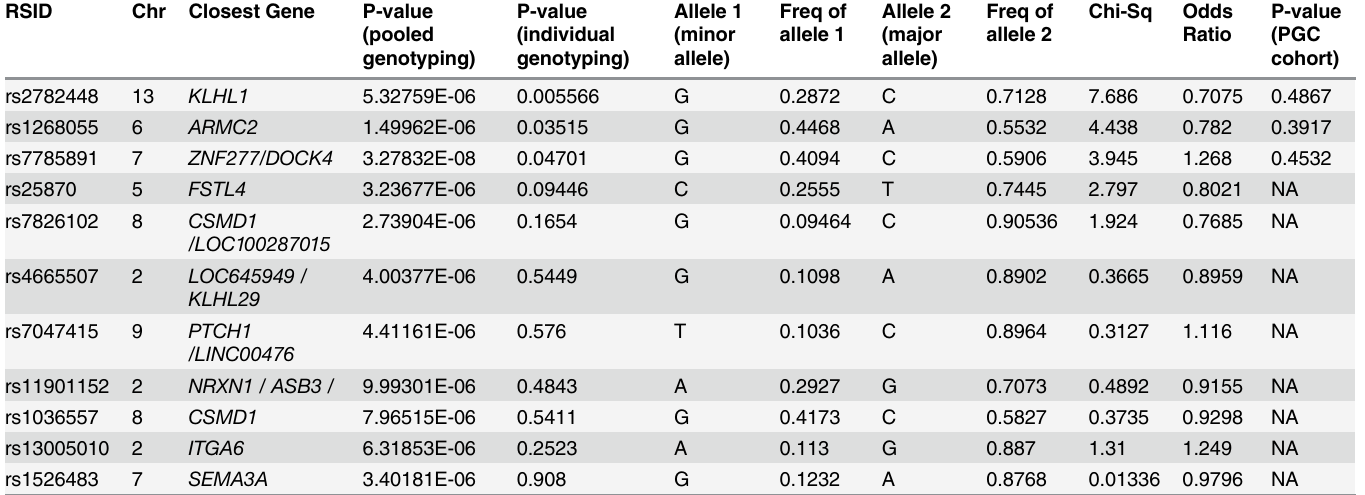
Table 1. Summary of results.